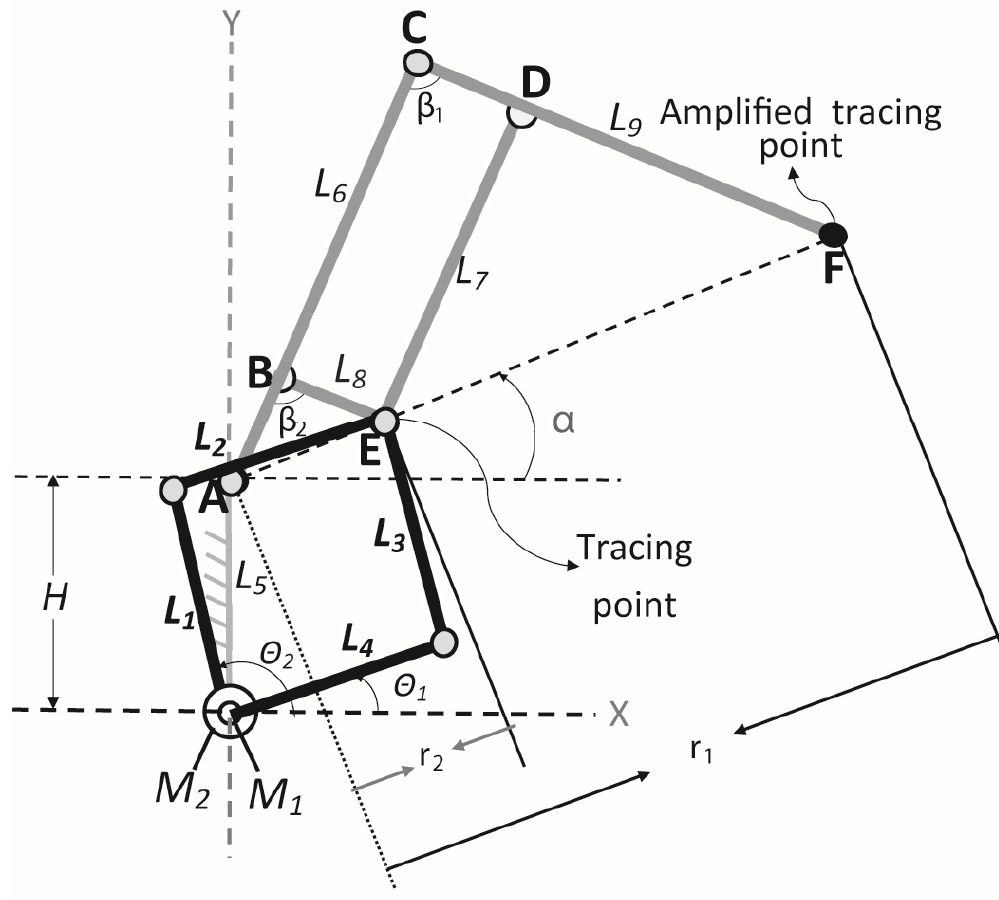
Figure 3. Proposed mechanism for arm motion assistance.